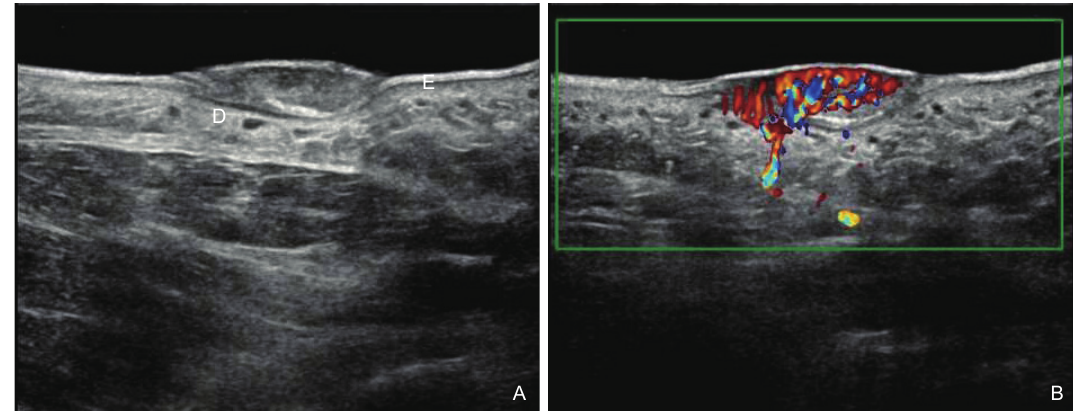
Figure 3 A eccrine poroma in epidermis (E). (A) Ultrasound revealed a 20×6 mm solid and well-defined hypoechoic nodule in epidermis (E); (B) Color Doppler showed cord-like blood flow